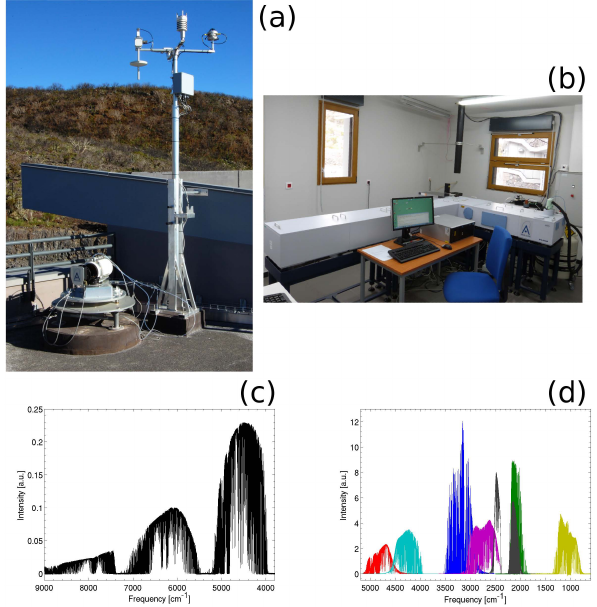
Fig. 6. (a) The sun tracker and meteorological station of the FTIR instrument. (b) The high-resolution Bruker IFS 125/HR infrared spectrometer in the room underneath the solar tracker. (c) A near- infrared spectrum collected according to the TCCON specifications on 18 April 2013. (d) Several mid-infrared spectra, collected using different NDACC optical filters and two different detectors (InSb and HgCdTe). These spectra were recorded on 28 May